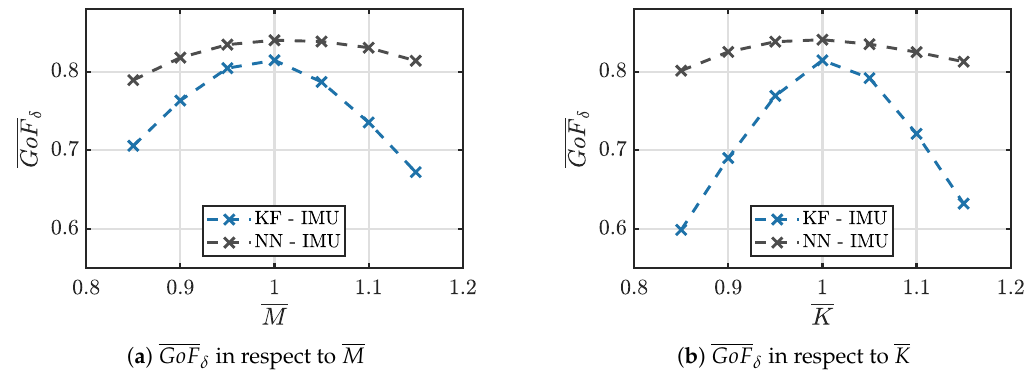
Figure 14. GoF δ comparison varying M ( a ) and K ( b ) for the IMU